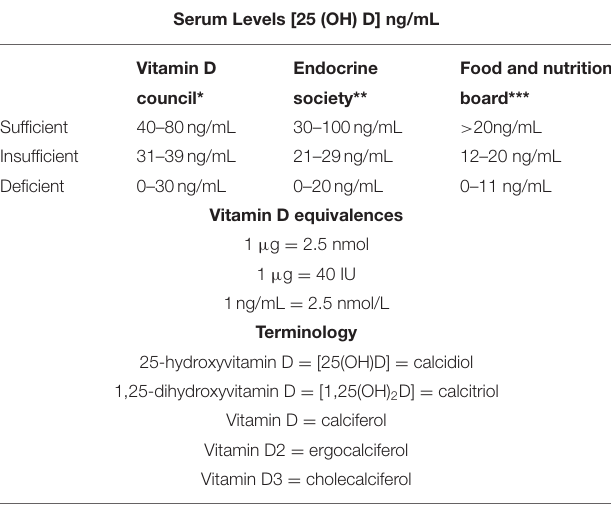
TABLE 1 | Vitamin D [25 (OH)D] range guidelines from various organizations, equivalences and terminology. Serum Levels [25 (OH) D]